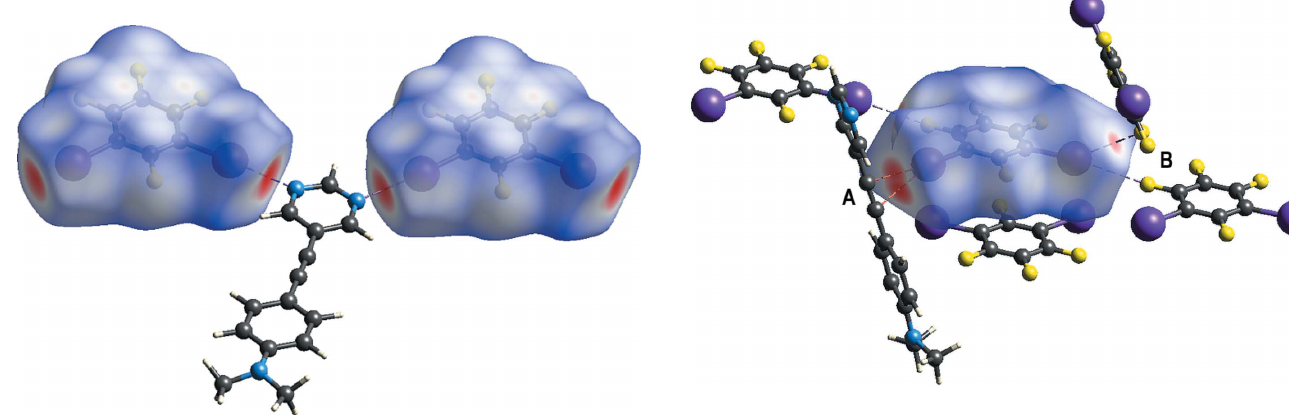
Figure 5 Hirshfeld surface highlighting the close contacts to the solvate 13DIFB molecule.